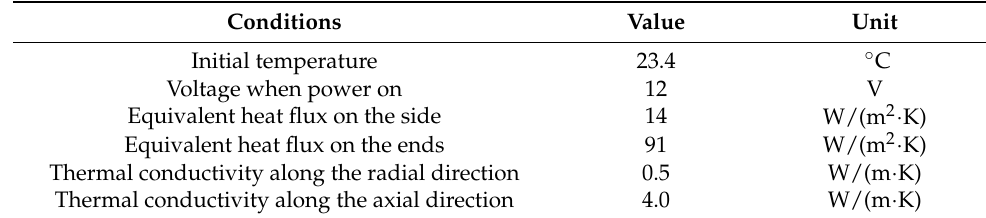
Table 4. Conditions of the simulation for the